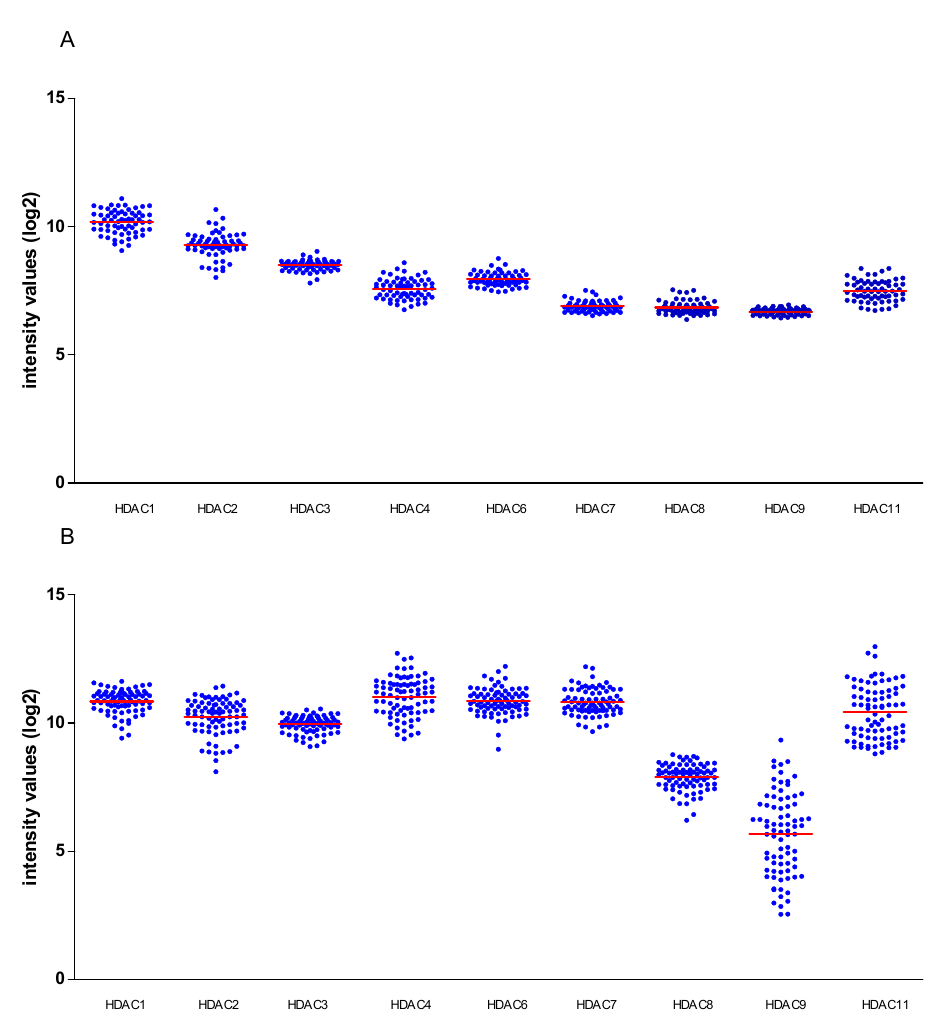
Figure 1. Distribution of HDAC mRNA in ( A ) 64 UM from Leiden; ( B ) 80 UM from the TCGA cohort. Horizontal bars indicate mean gene expression.